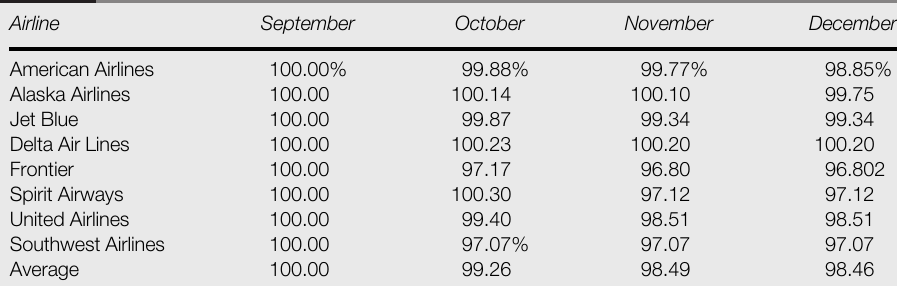
Table 1 Planned vs actual scheduled capacity in 2019